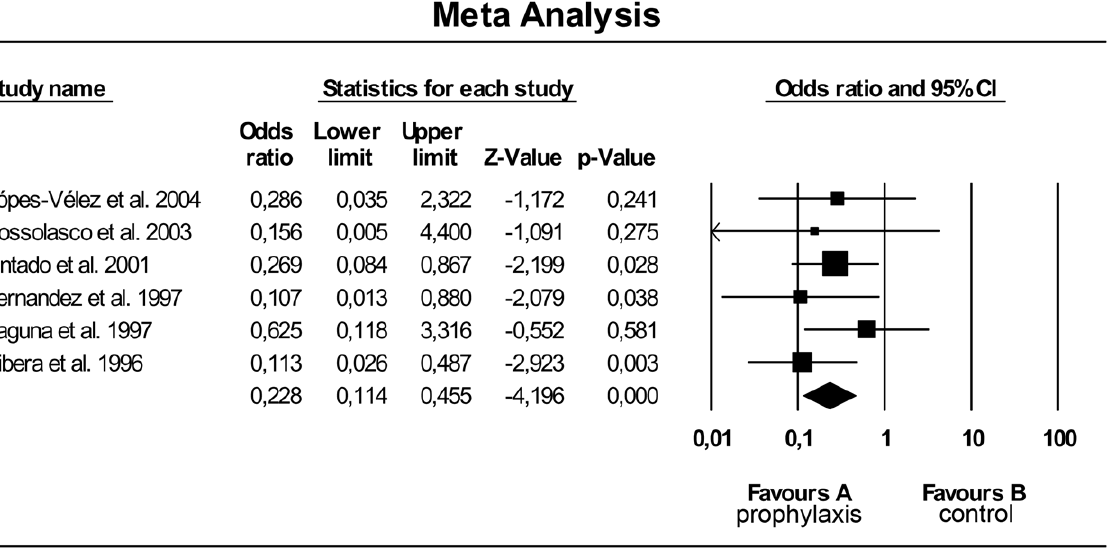
Figure 3. Meta-analysis of secondary prophylaxis results. Footnote: I 2 =0% Egger test for publication bias was negative, p=0.76.